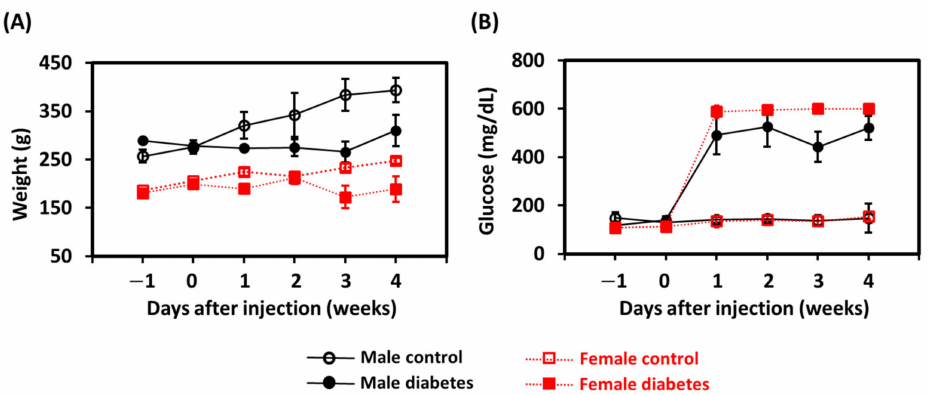
Figure 1. Weekly ( A ) weight and ( B ) plasma glucose level measurements for animals in the control and diabetes groups between sexes.